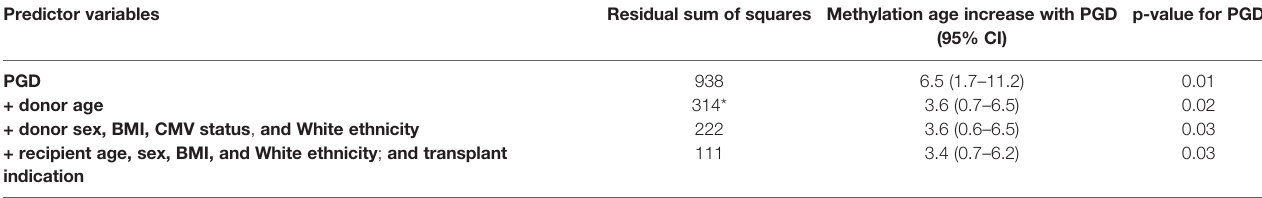
TABLE 2 | PGD effect in sequential regression models of airway methylation age. Predictor variables Residual sum of squares Methylation age increase with PGD